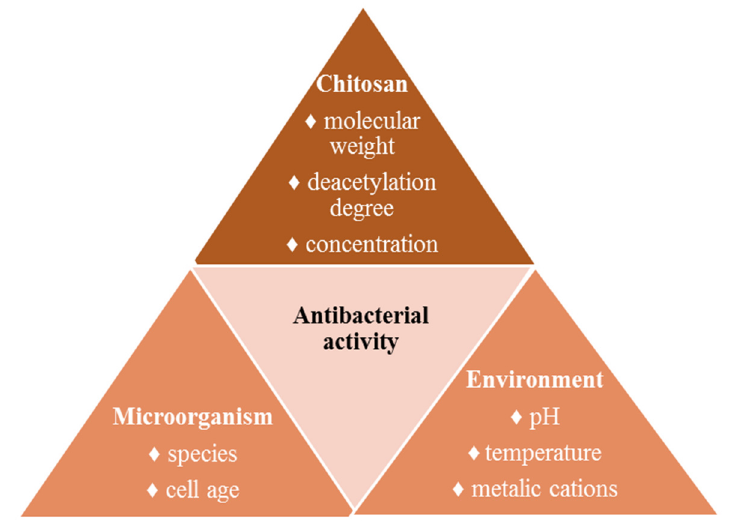
Figure 9. Factors that influence the antibacterial activity of chitosan.